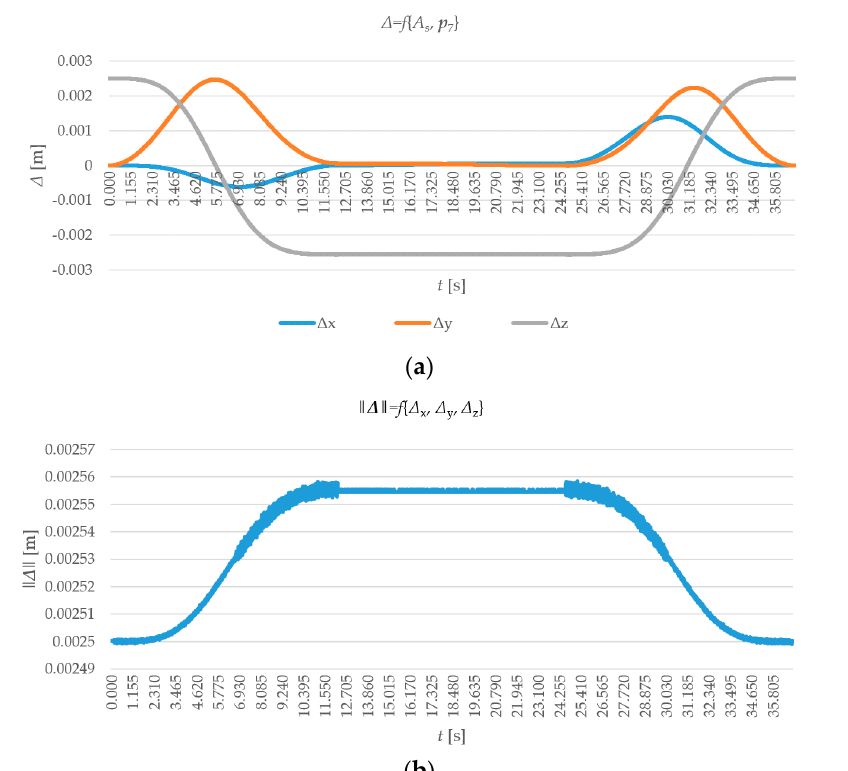
Figure 12. ( a ) A graph showing the Δ x , Δ y , Δ z difference between the real trajectory (composed of A s { x As , y As , z As } points) and the one calculated (from the components of the position vector effector